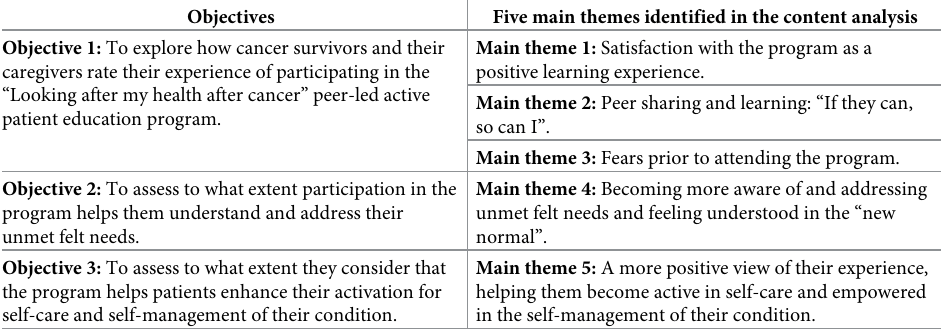
Table 3. Relationship between the study objectives and themes that emerged in the focus groups. Objectives Five main themes identified in the content analysis